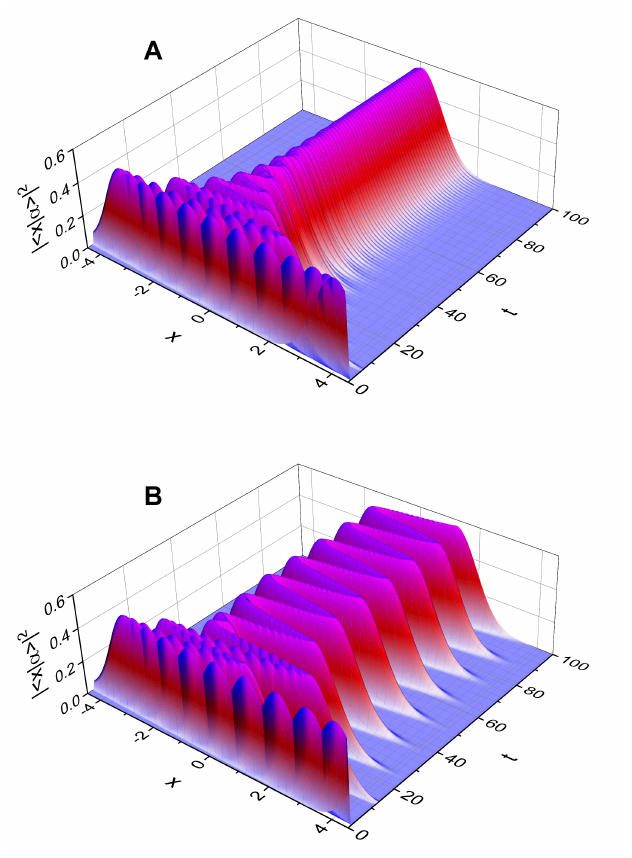
Figure 5. Time evolution of the probability density |(cid:104) x | α (cid:105)| 2 for ω = 5 ( A ) and ω = 0.5 ( B ). The values that we have used are γ e = 0.2, ω e = 1, ϕ = 0, α 0 = 3, m = 1, ¯ h = 1, and f d =